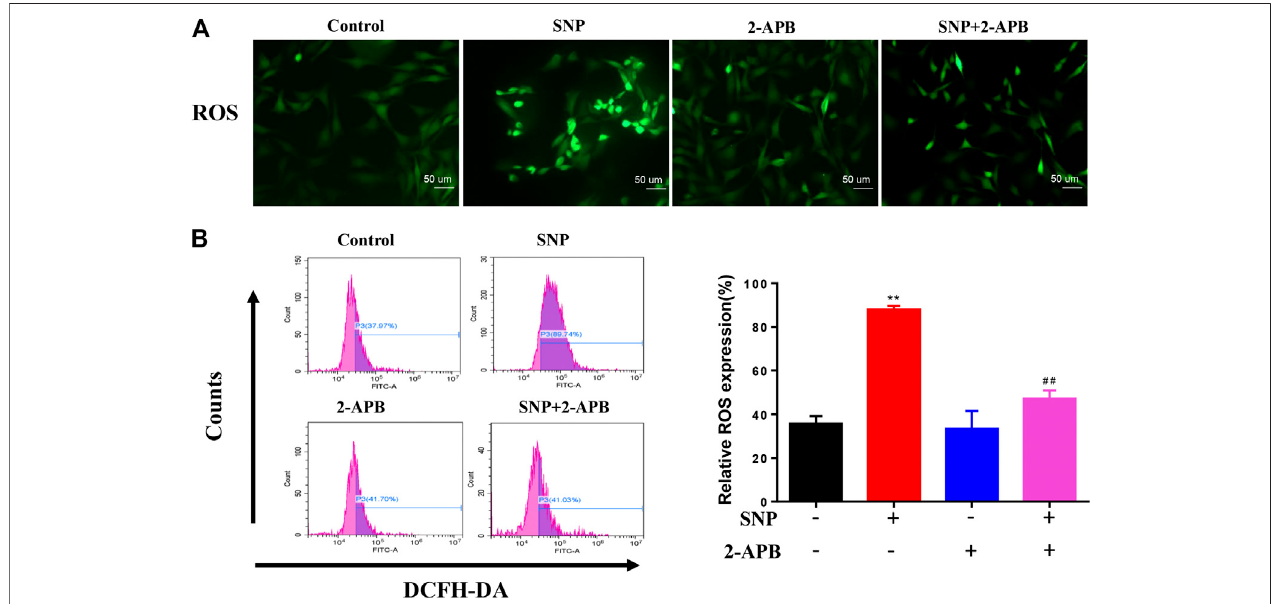
FIGURE 3 | 2-APB suppresses SNP-induced ROS expression (A) DCFH-DA stain of 2-APB on SNP-induced ROS expression (B) Quantitative analysis of 2-APB on SNP-induced ROS expression with fl ow cytometry. Chondrocytes were seeded in 6-well plates cultured for 24 h, then treated with 2-APB (100 μ M) and SNP (0.5 mM) for 12 h. Values are presented as mean ± SEM. n (cid:2) 3, ** p < 0.01, compared with control group; ## p < 0.01, compared with SNP